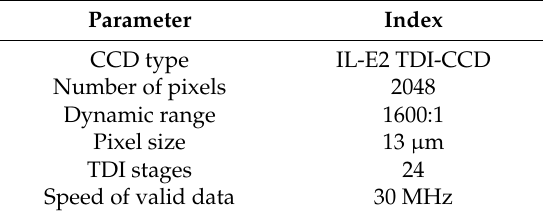
Table 2. Main indexes of camera and TDI-CCD.